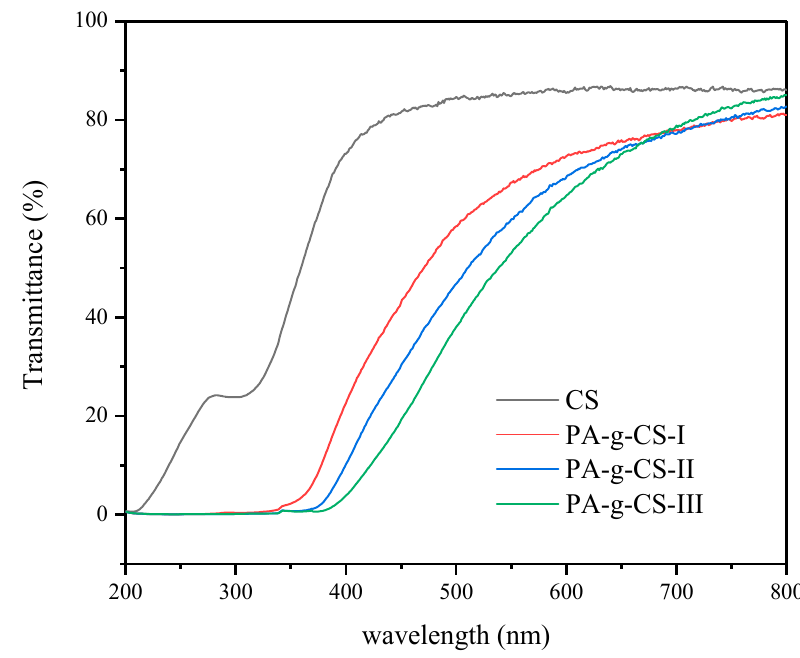
Figure 3. Light transmission of the CS and PA-g-CS (I-III) films.